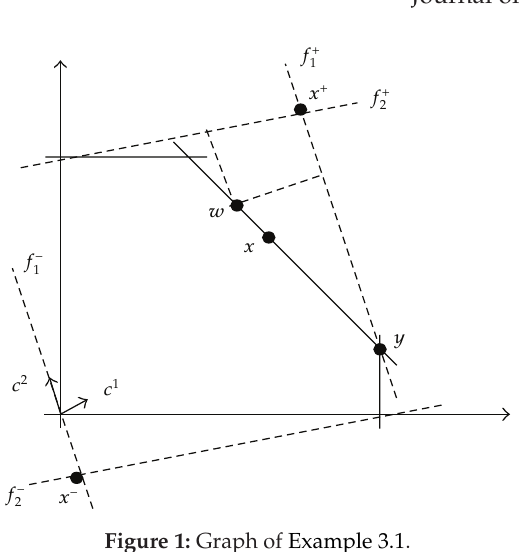
Figure 1: Graph of Example